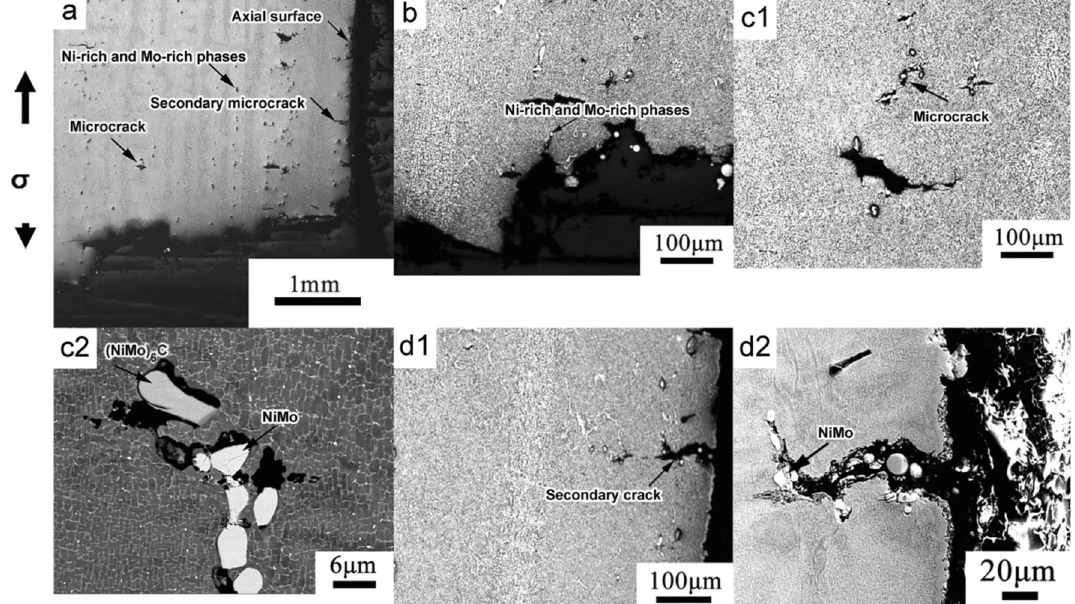
Figure 4: Microstructures of the fracture longitudinal section of the single crystal alloy IC6SX with [001] orientation after being crept for 56.3h and then up to fracture at 850 ° C/450 MPa. (a) Macroscopic metallographic structure (OM image); (b) fracture surface cracks (OM image); (c1) microcracks in the interior of the matrix (OM image); (c2) microcracks in the interior of the matrix (SEM image); (d1) secondary crack on the axial surface (OM image); (d2) secondary crack on the axial surface (SEM